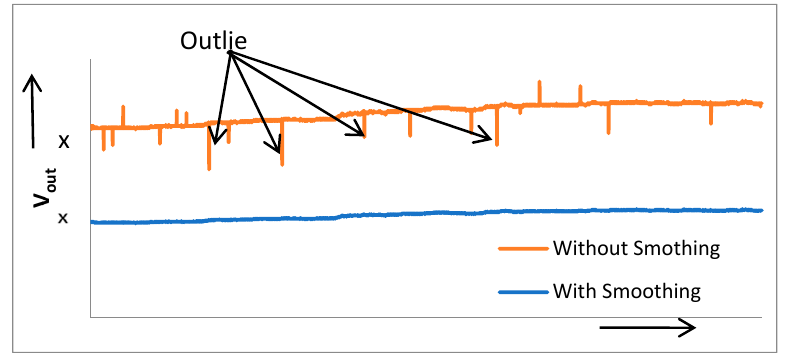
Figure 12. Sensors raw sata with and without smoothing algorithm.